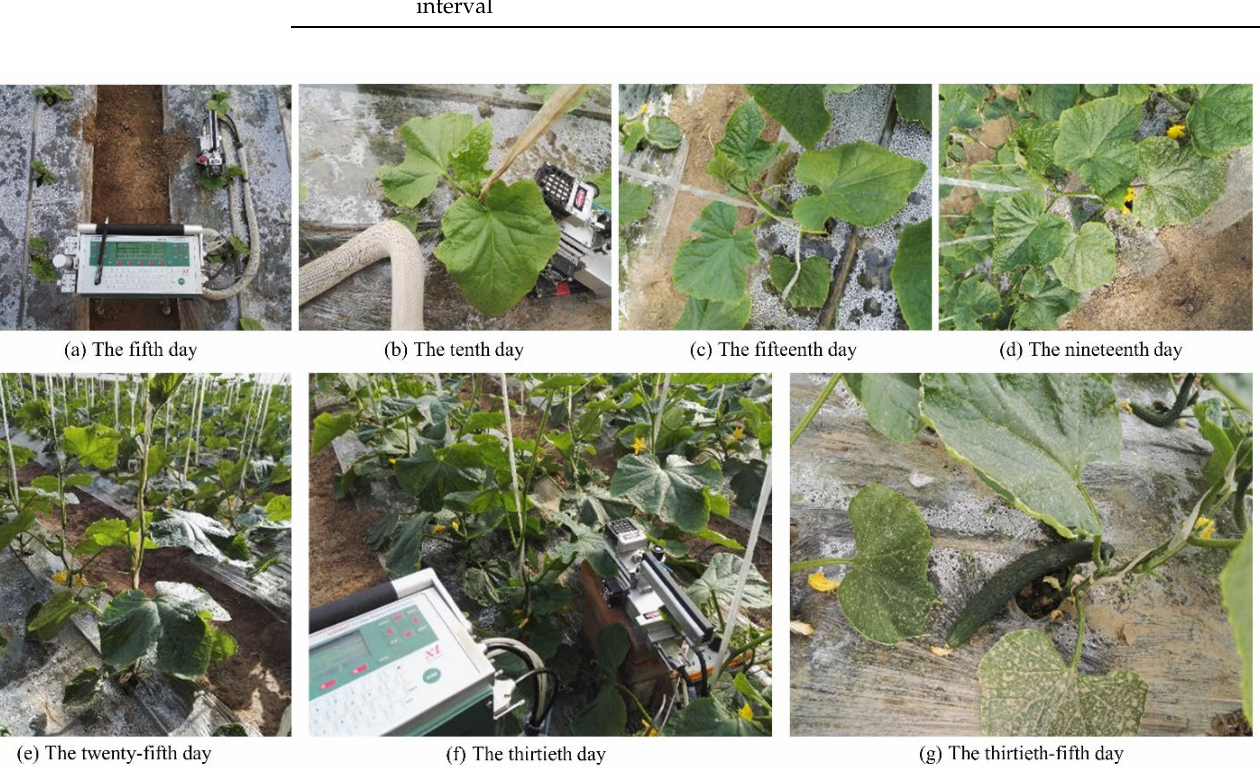
Figure 2. The growth status of cucumbers in different